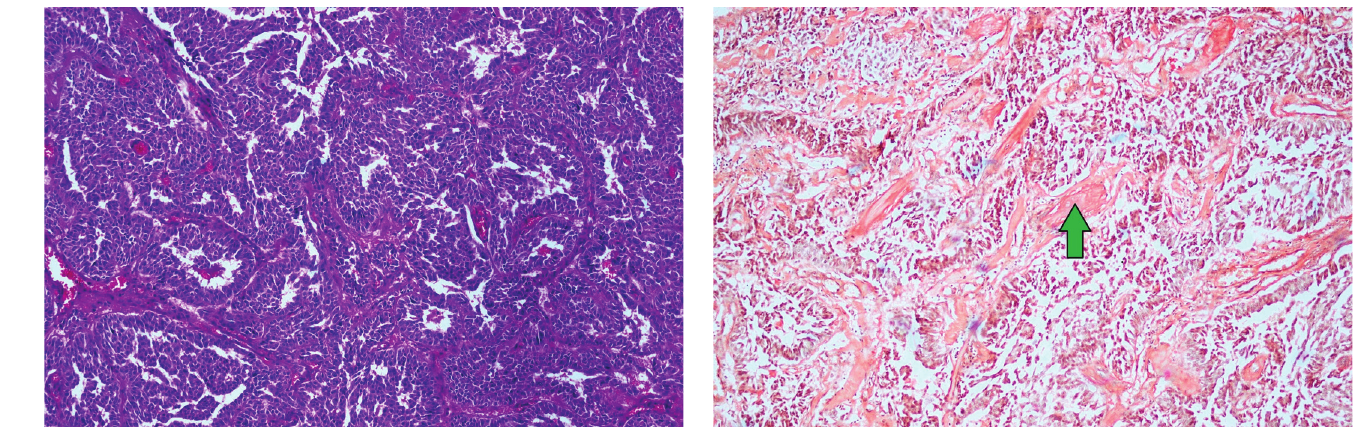
Figure 3 B - Amyloid (green arrow) seen as reddish with